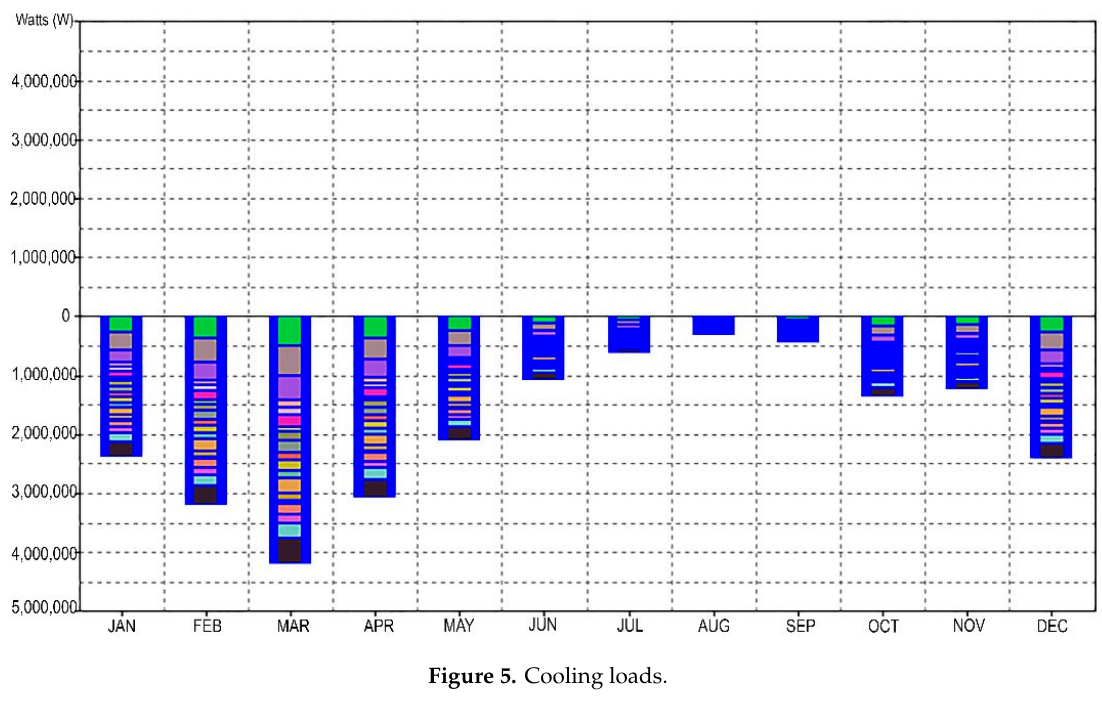
Buildings 2018 , 8 , x FOR PEER REVIEW